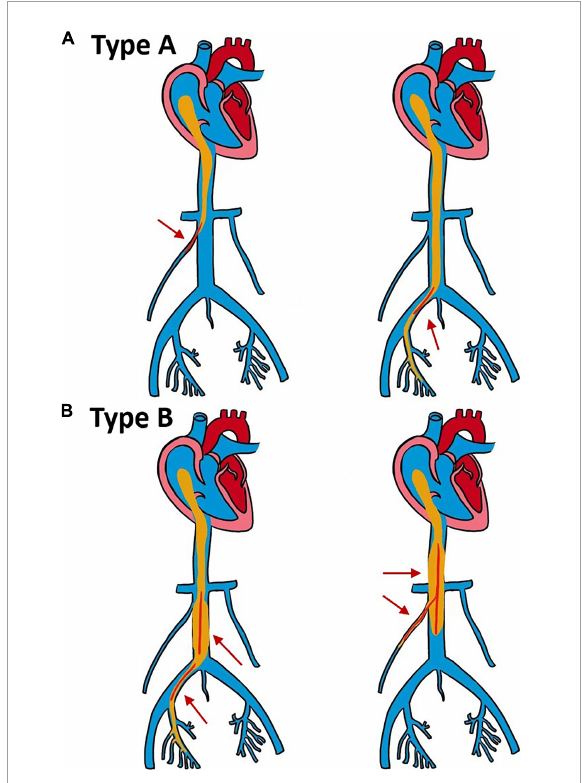
FIGURE2 Schematic diagram of two different types of surgery. (A,B) The maximum diameter of the intracardiac tumor is smaller than the diameter of the inlet of the right atrium (RA). (A) The maximum diameter of the tumor in the inferior vena cava (IVC) is smaller than the maximum diameter of the infrarenal IVC, and the tumor can be removed by a short venotomy (red arrow). (B) The maximum diameter of the tumor in the IVC is larger than the maximum diameter of the infrarenal IVC, and extensive venotomy is required to remove the tumor (red